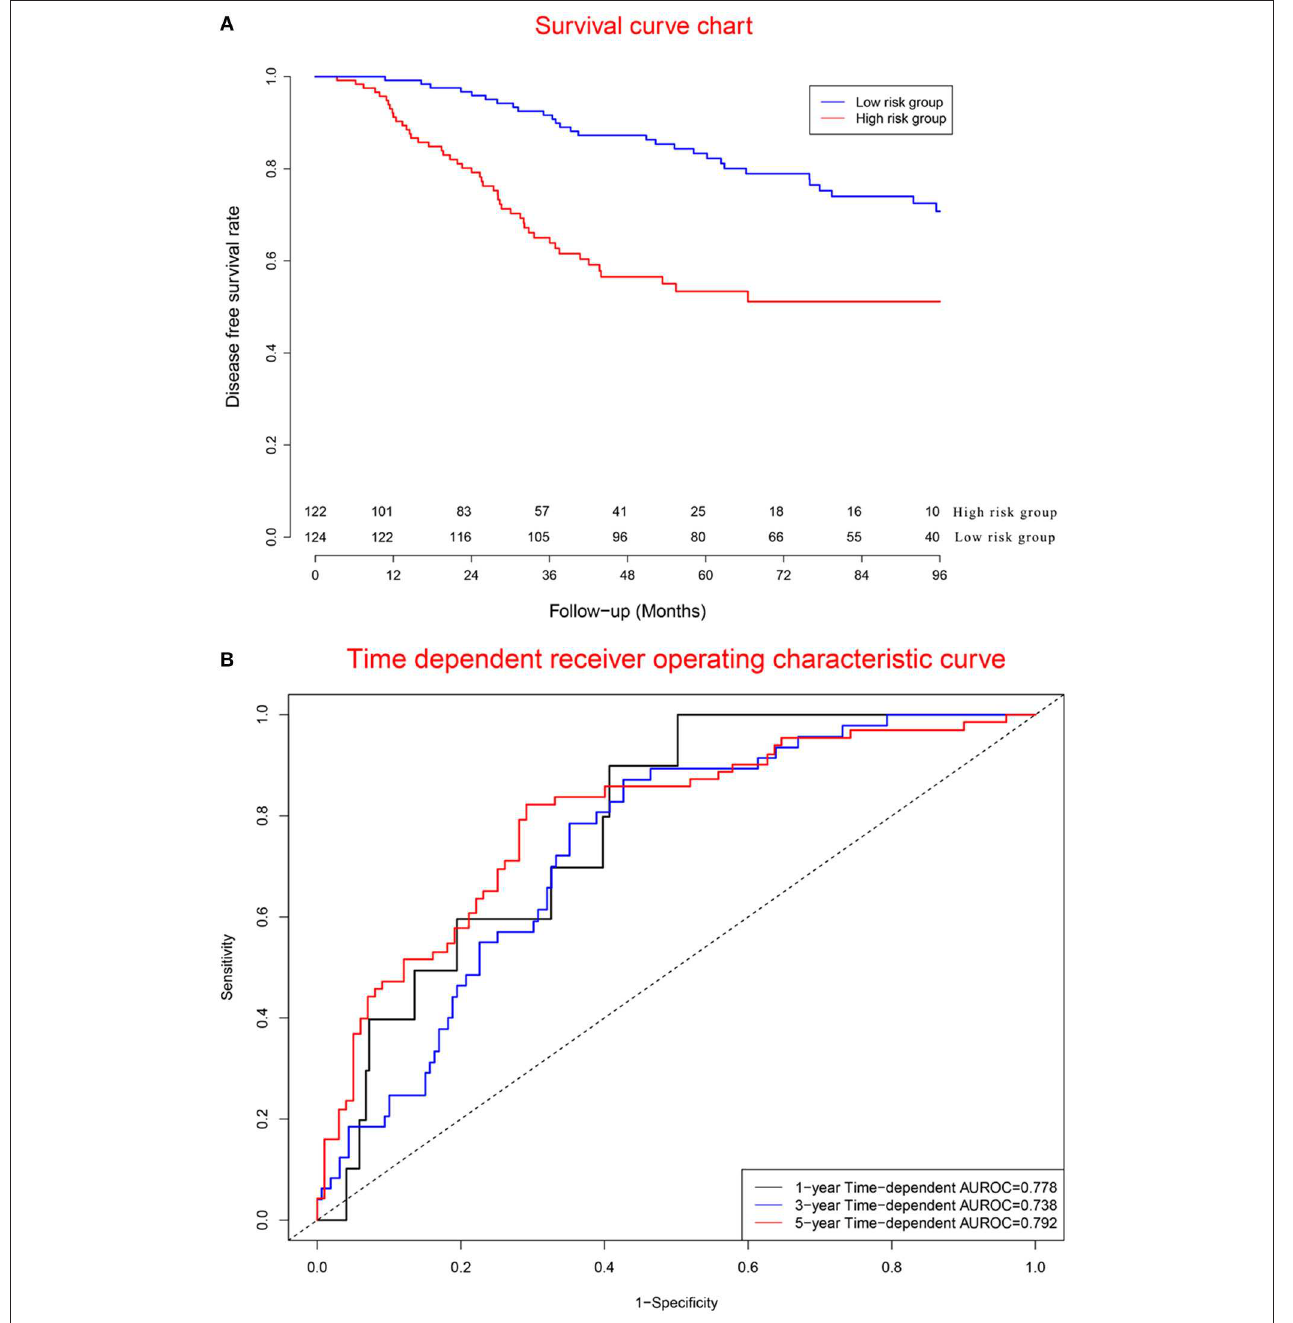
FIGURE 7 | Clinical performance in validation cohort. (A) Survival curves for high risk group and low risk group. (B) Time-dependent receiver operating characteristic